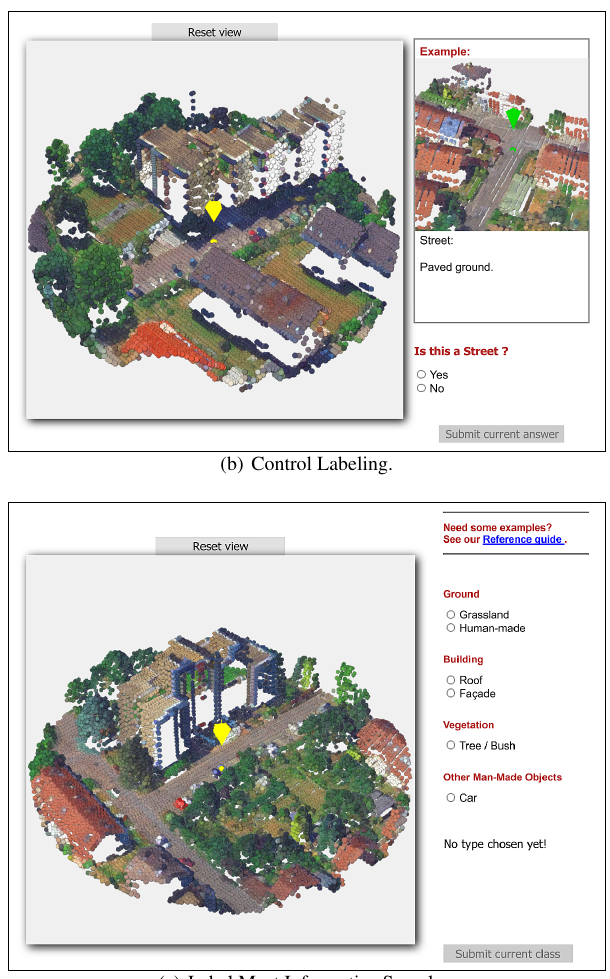
Figure 2. Web-based tools used by crowdworkers. Every website further contains brief instructions and an example.